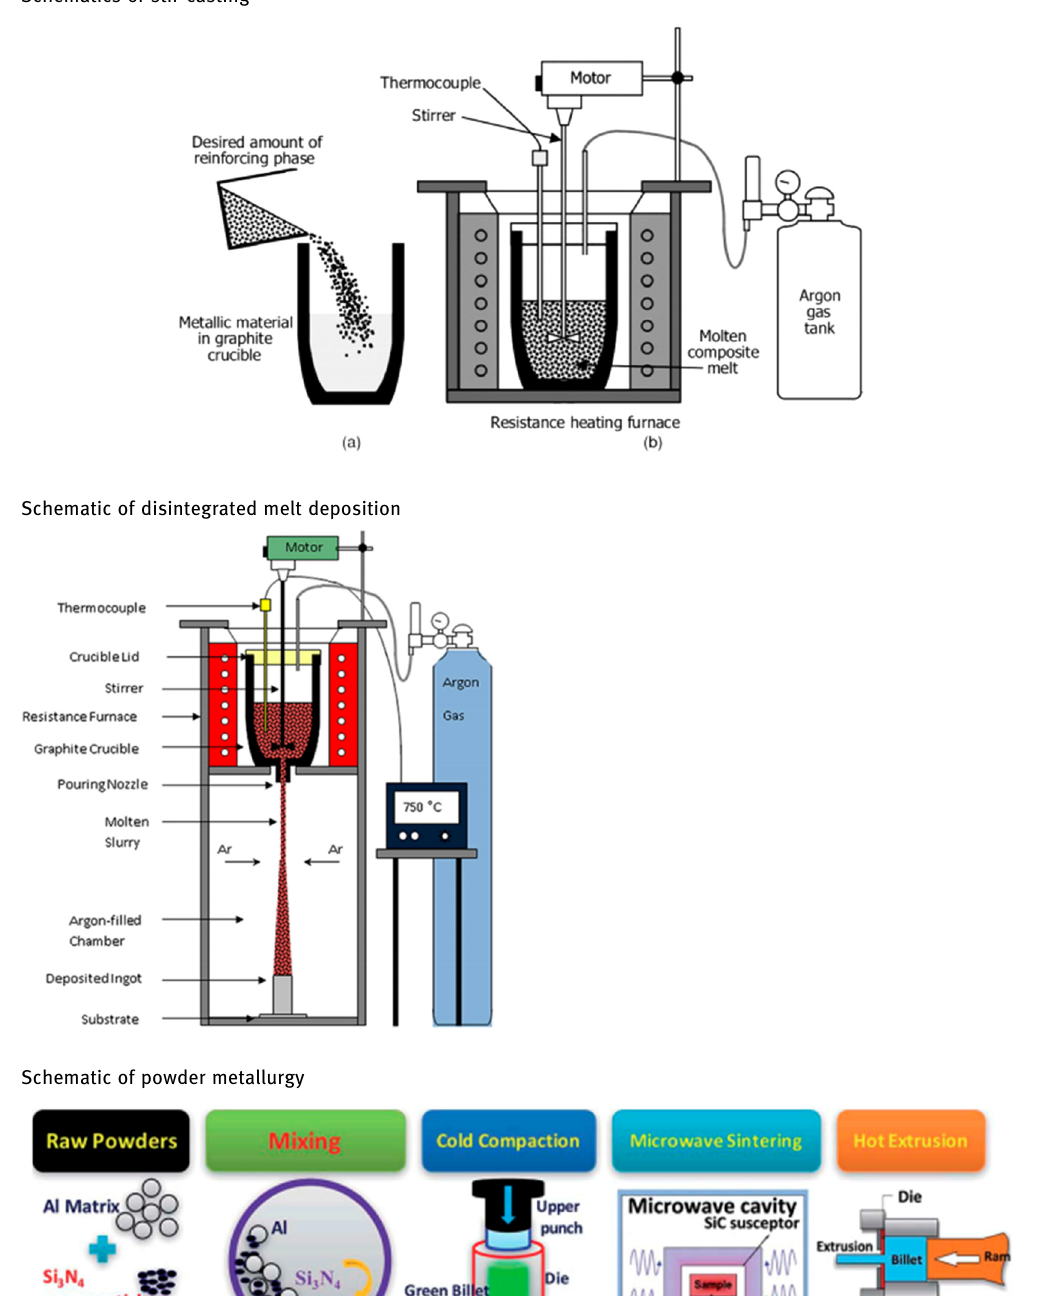
Table 14: Various fabrication methods of MMNCs Schematics of stir -